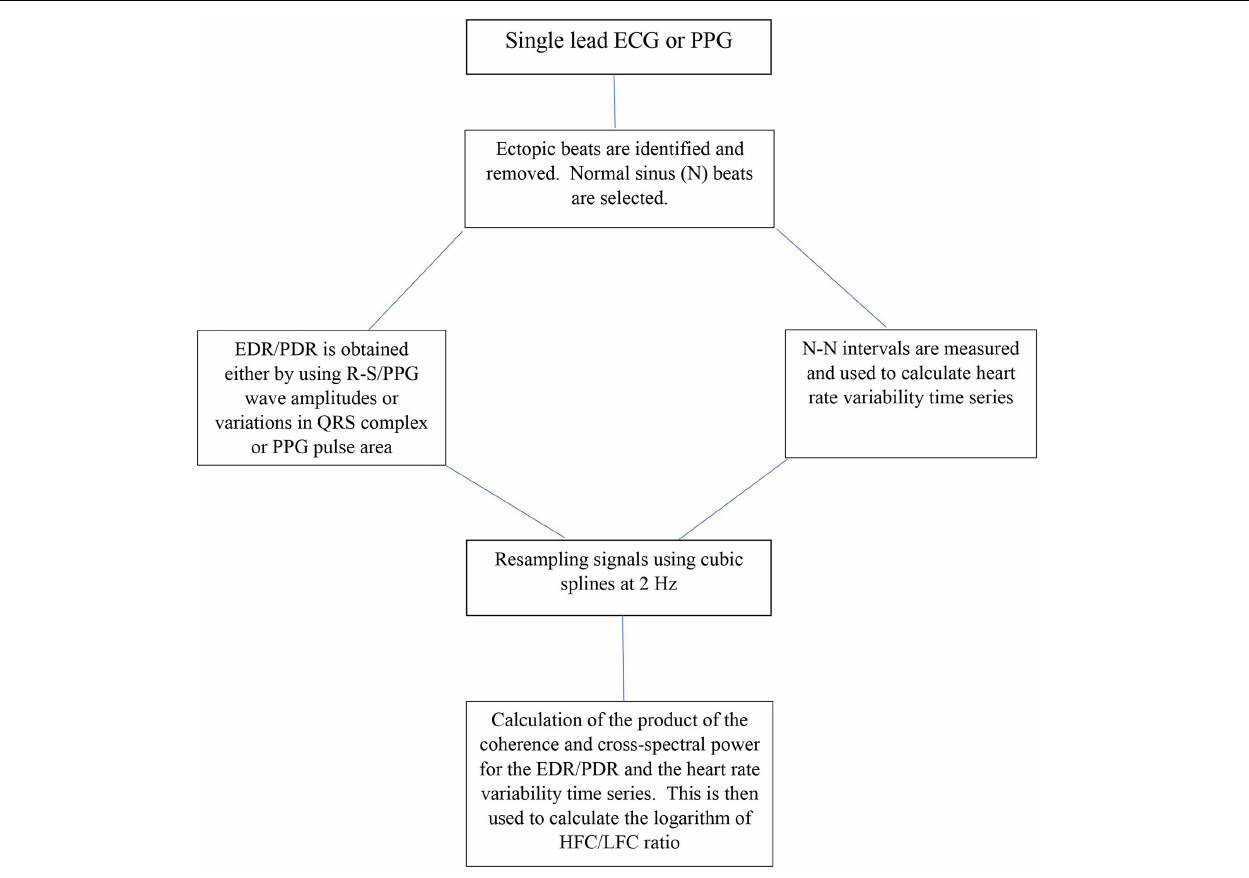
FIGURE 1 | Schematic for CPC analysis. ECG, Electrocardiogram; PPG, Photoplethysmogram; EDR, ECG-derived respiration; PDR, Photoplethysmogram derived respiration R-S and QRS are ECG waveforms; N-N intervals, Normal sinus to normal sinus intervals; Hz, frequency; HFC, high frequency coupling; LFC, low frequency